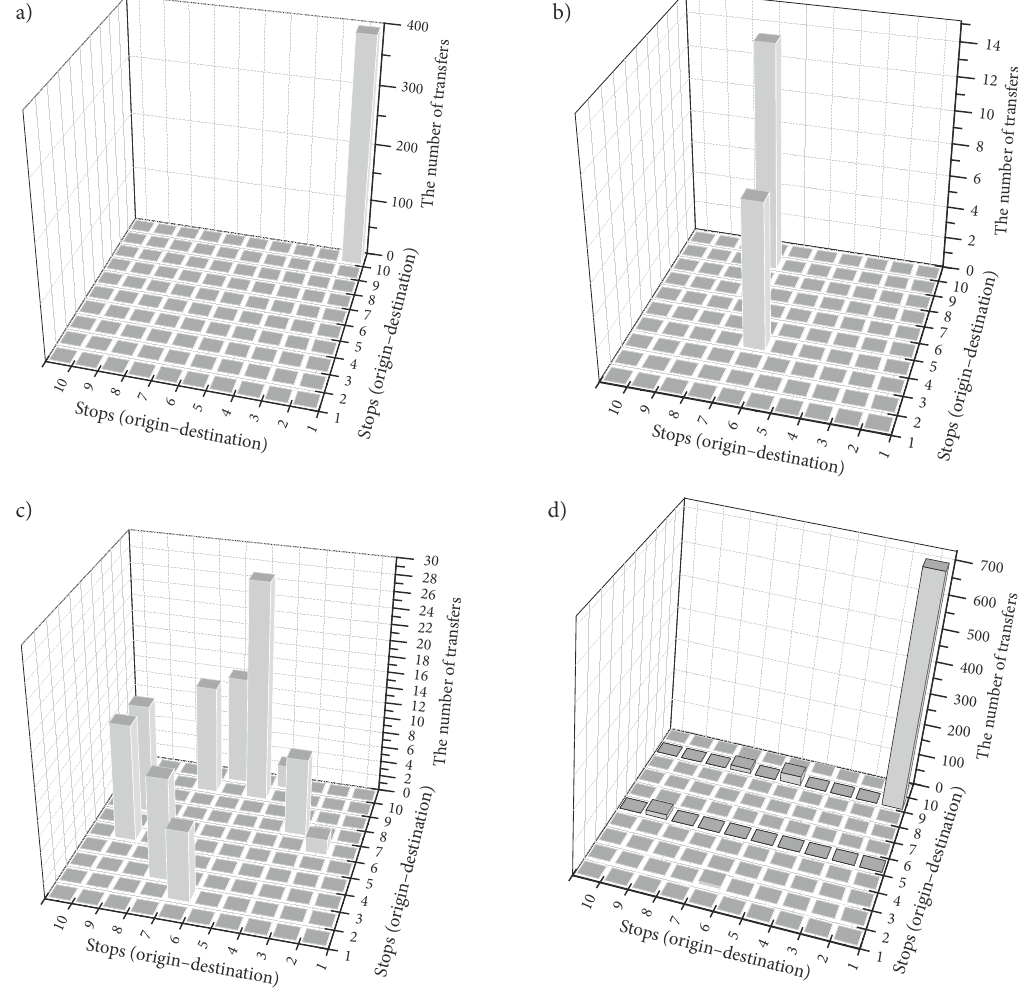
Figure 10. A change of O–D pairs transfer with the increment of β ij : a – β ij = 0; b – β ij = 0.05; c – β ij = 0.1; d – β ij = 0.2